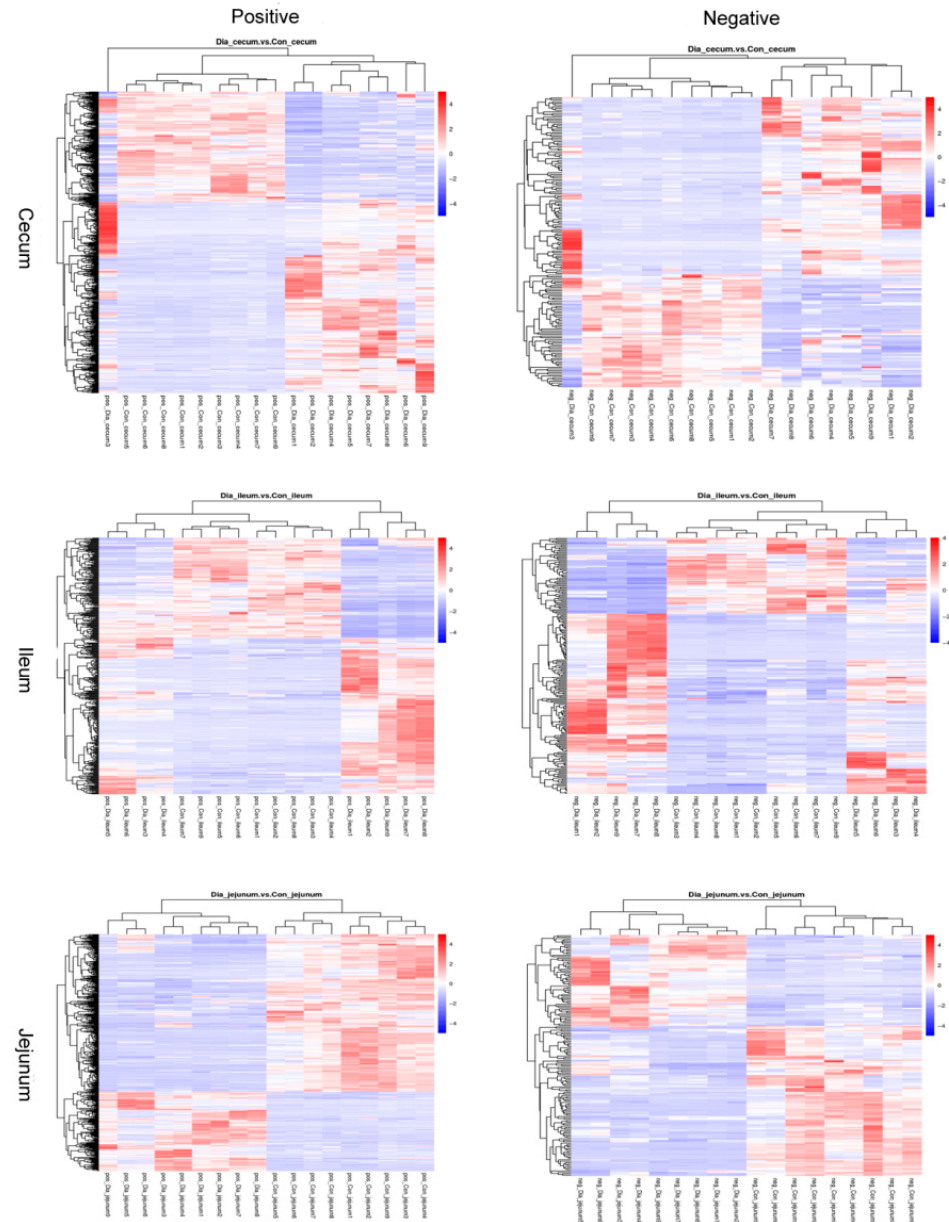
Figure 4. The difference in cluster heat maps of jejunum, ileum, and cecum tissue samples for the positive and negative ion